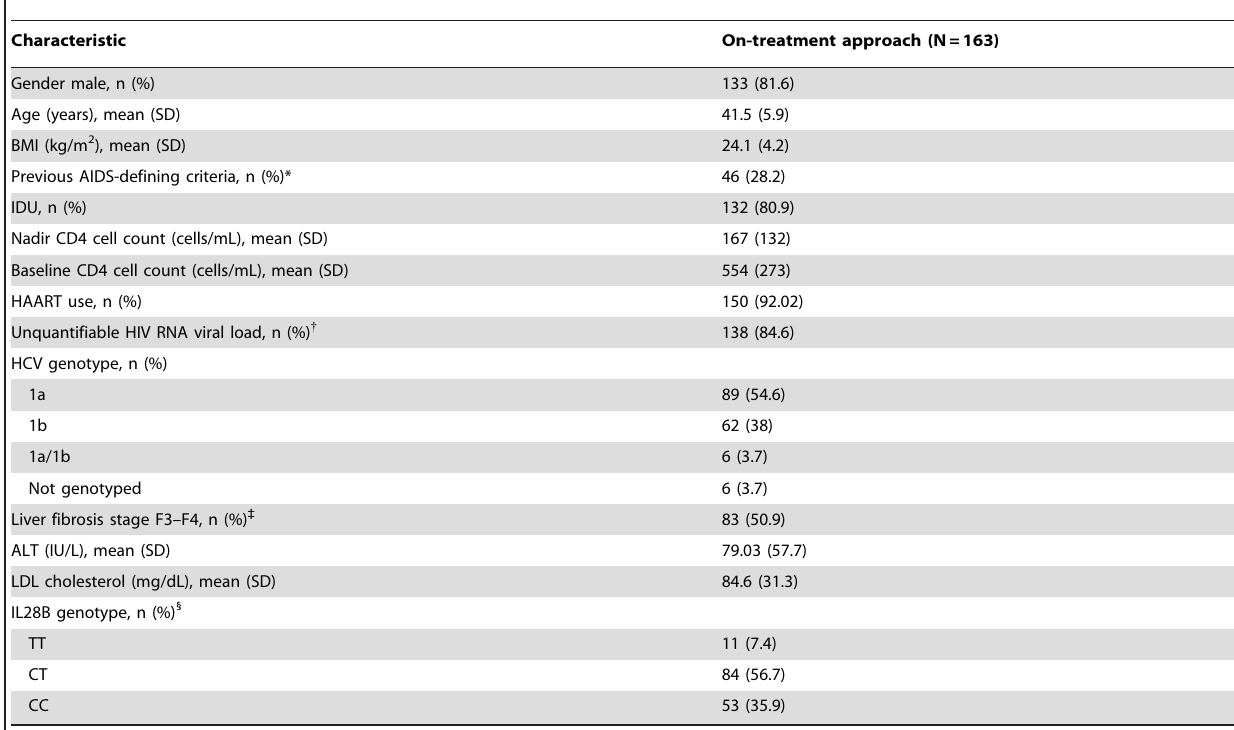
Table 1. Demographic, virological and clinical characteristics of the on-treatment population.